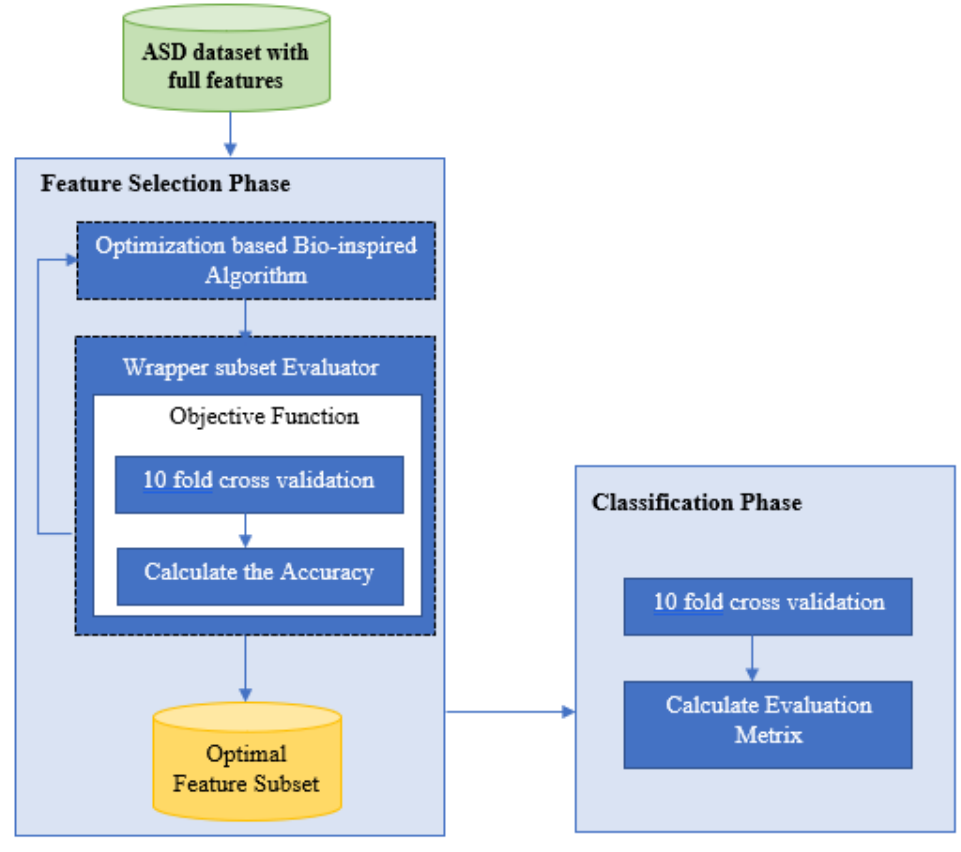
Figure 2. The general framework of the proposed models.